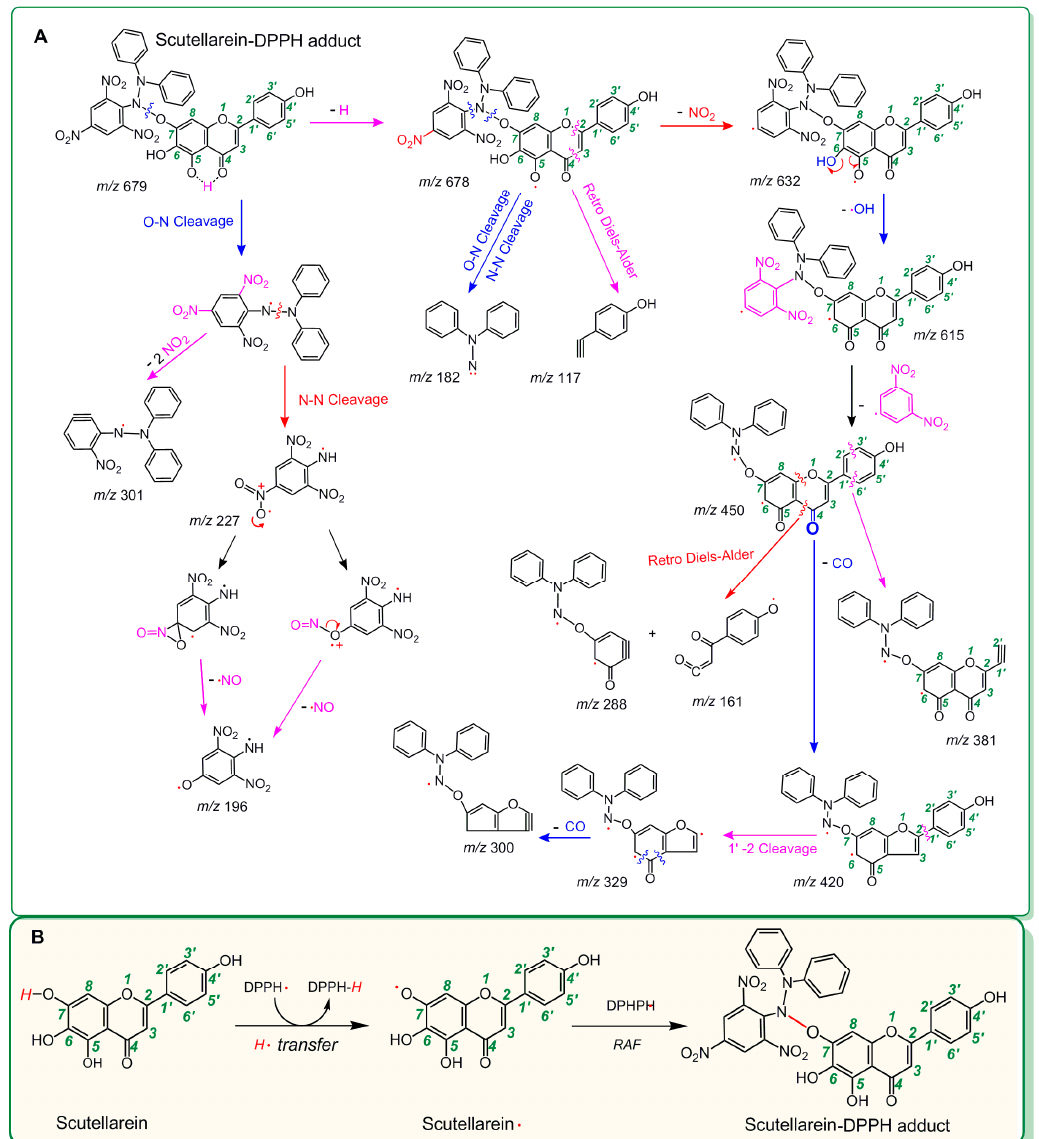
Figure 3. MS elucidation of the scutellarein-DPPH adduct structure ( A ) and the proposed reaction for the formation of the scutellarein-DPPH adduct ( B ). (The MS spectra are in negative ion mode, and the charge imposed by the MS field is not marked. Other linking sites between the scutellarein moieties and the DPPH moiety should not be excluded; other reasonable cleavages should not be excluded in the MS elucidation.).